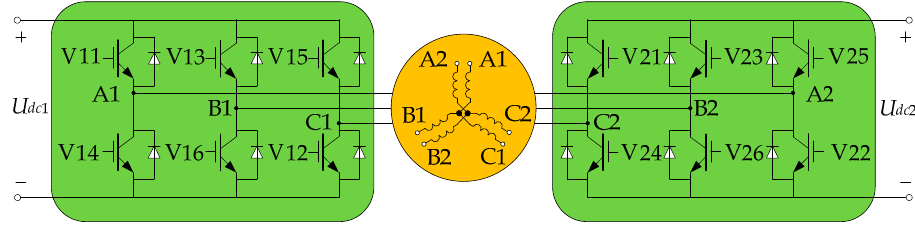
Figure 3. Structure and drive system topology structure of the DRPMSM.